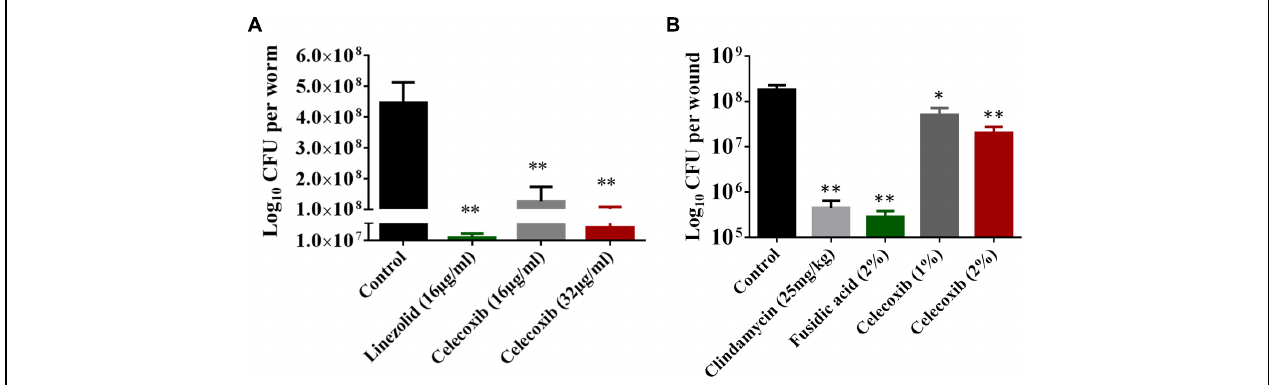
FIGURE 4 | Efficacy of celecoxib in MRSA-infected animal models. (A) L4-stage worms infected with MRSA USA300 were treated with celecoxib (16 and 32 μ g/ml) and linezolid (16 μ g/ml) for 24 h. At this point, the worms were disrupted and the amount of MRSA in the lysate (CFU) was determined. CFU per worm in treated groups relative to the untreated control groups were shown. Triplicate wells were used for each group and the results were